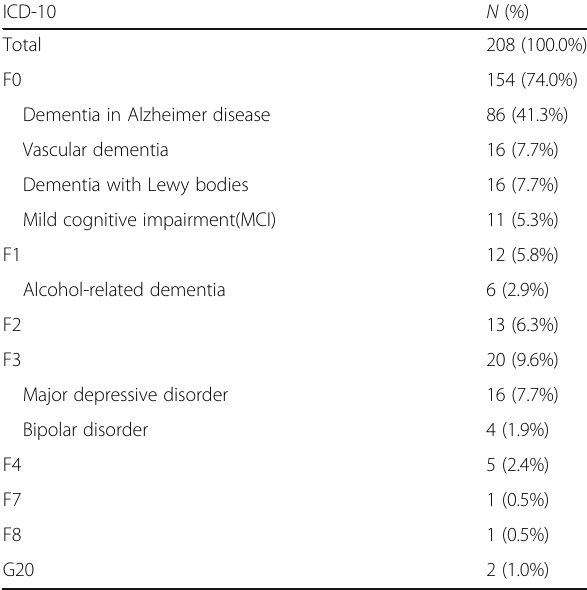
Table 1 Diagnosis and number of